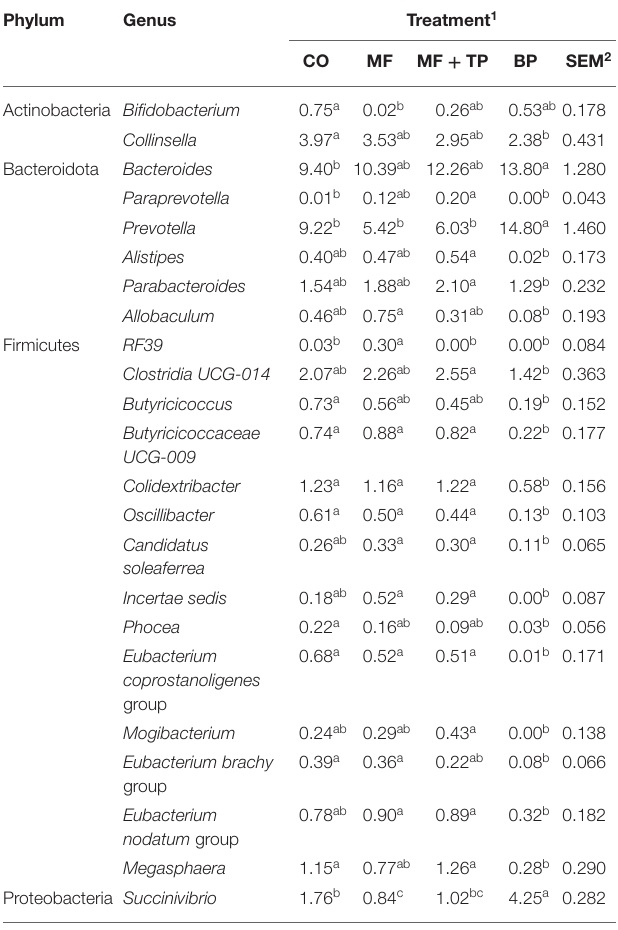
TABLE 6 | Fecal microbial composition (%) at the genus level for cats fed treatments containing traditional and novel fiber sources. Phylum Genus